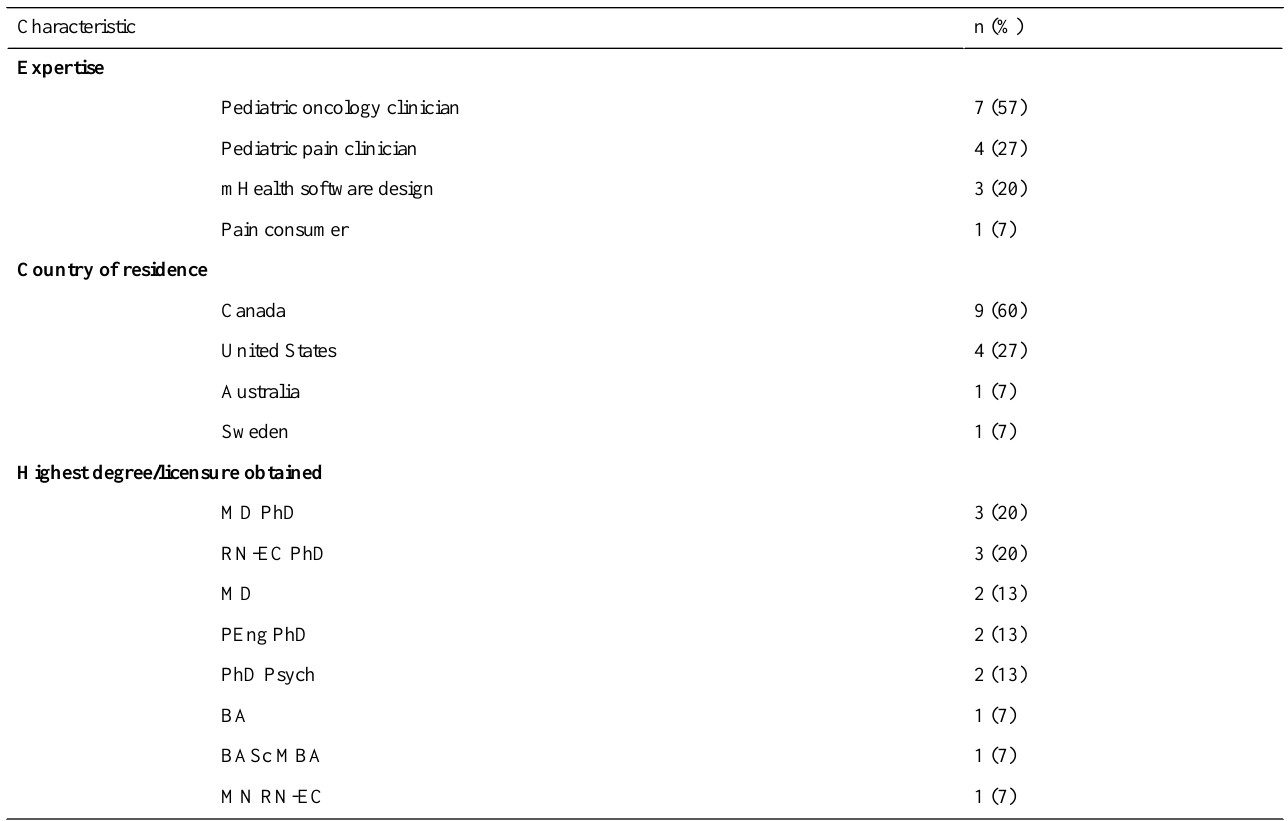
Table 1. Consensus conference participant characteristics